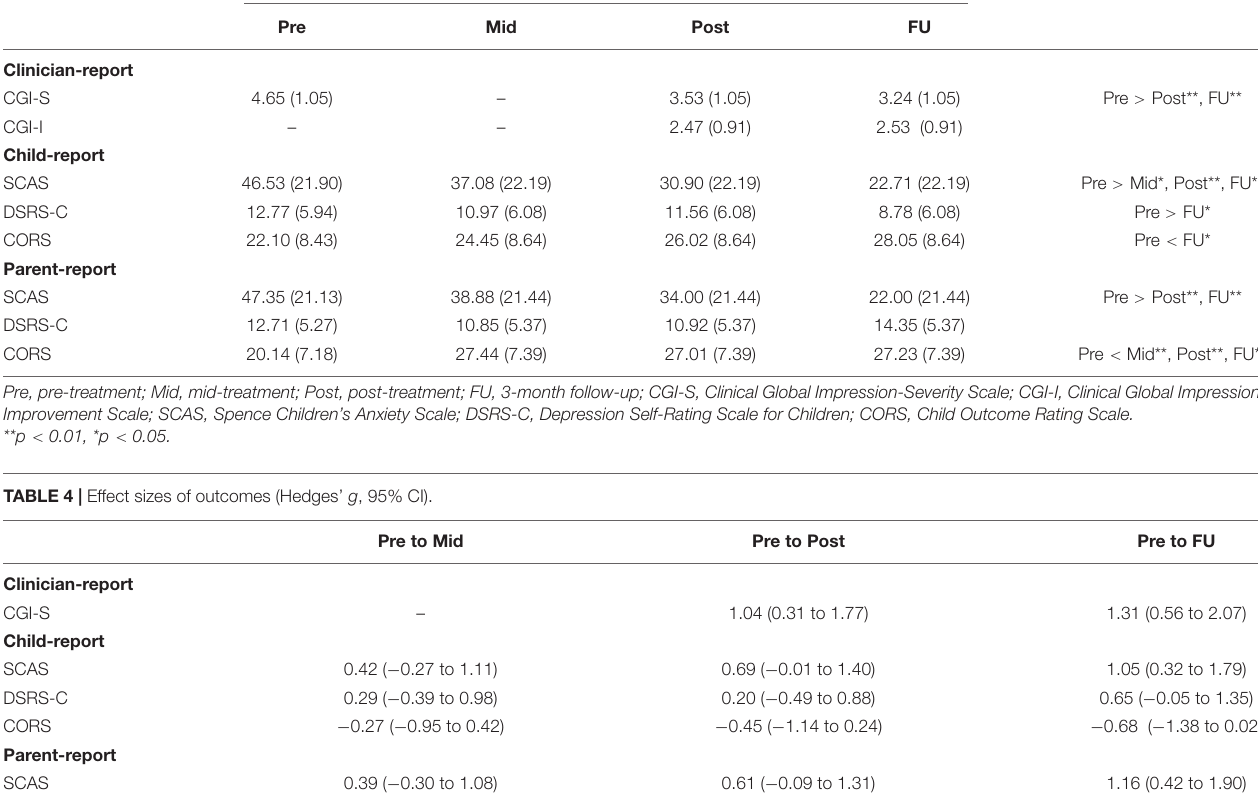
TABLE 3 | Scores of outcomes and the differences in scores between pre-treatment and other time points.